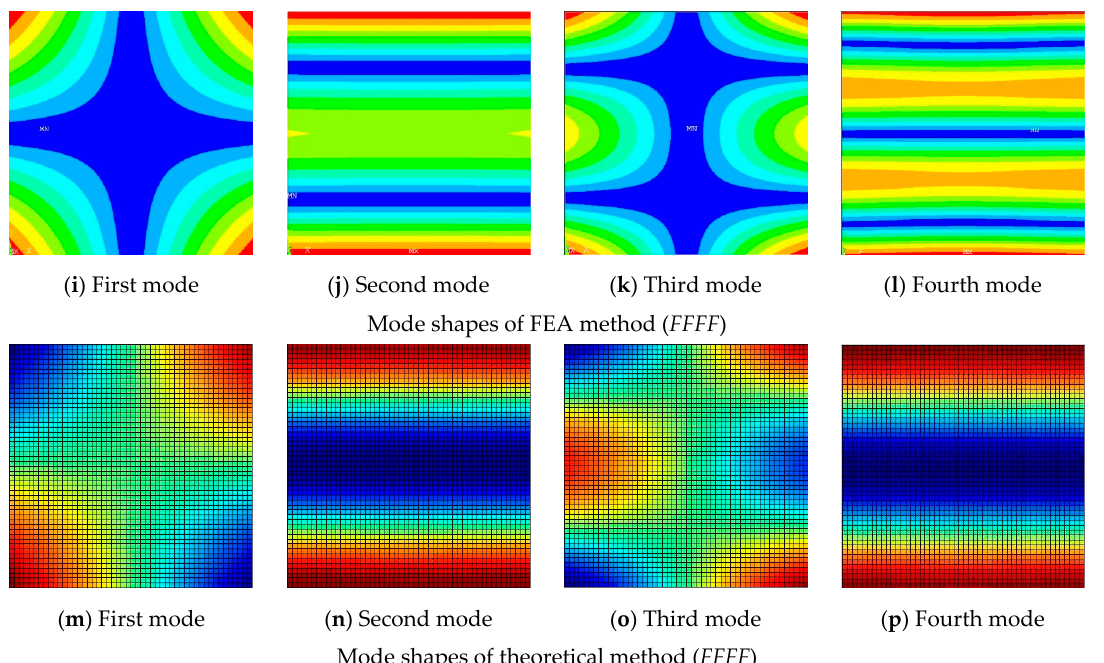
Figure 3. Mode shapes of the composite laminated plate. ( a , e , i , m ) First mode, ( b , f , j , n ) Second mode, ( c , g , k , o ) Third mode, ( d , h , l , p ) Fourth mode.